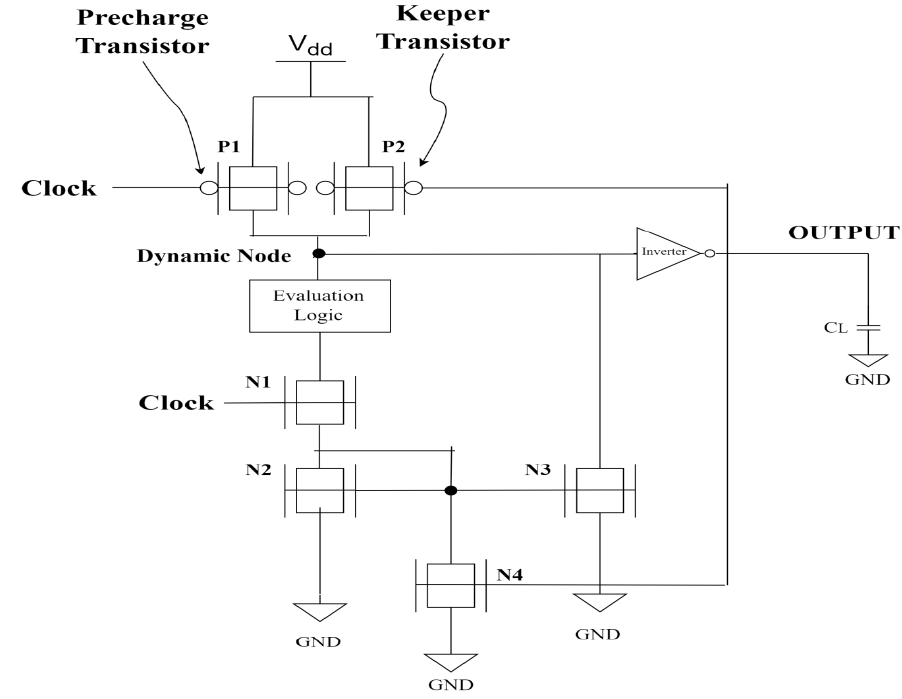
Figure 7. Current mirror-footed domino (CMFD) [26].